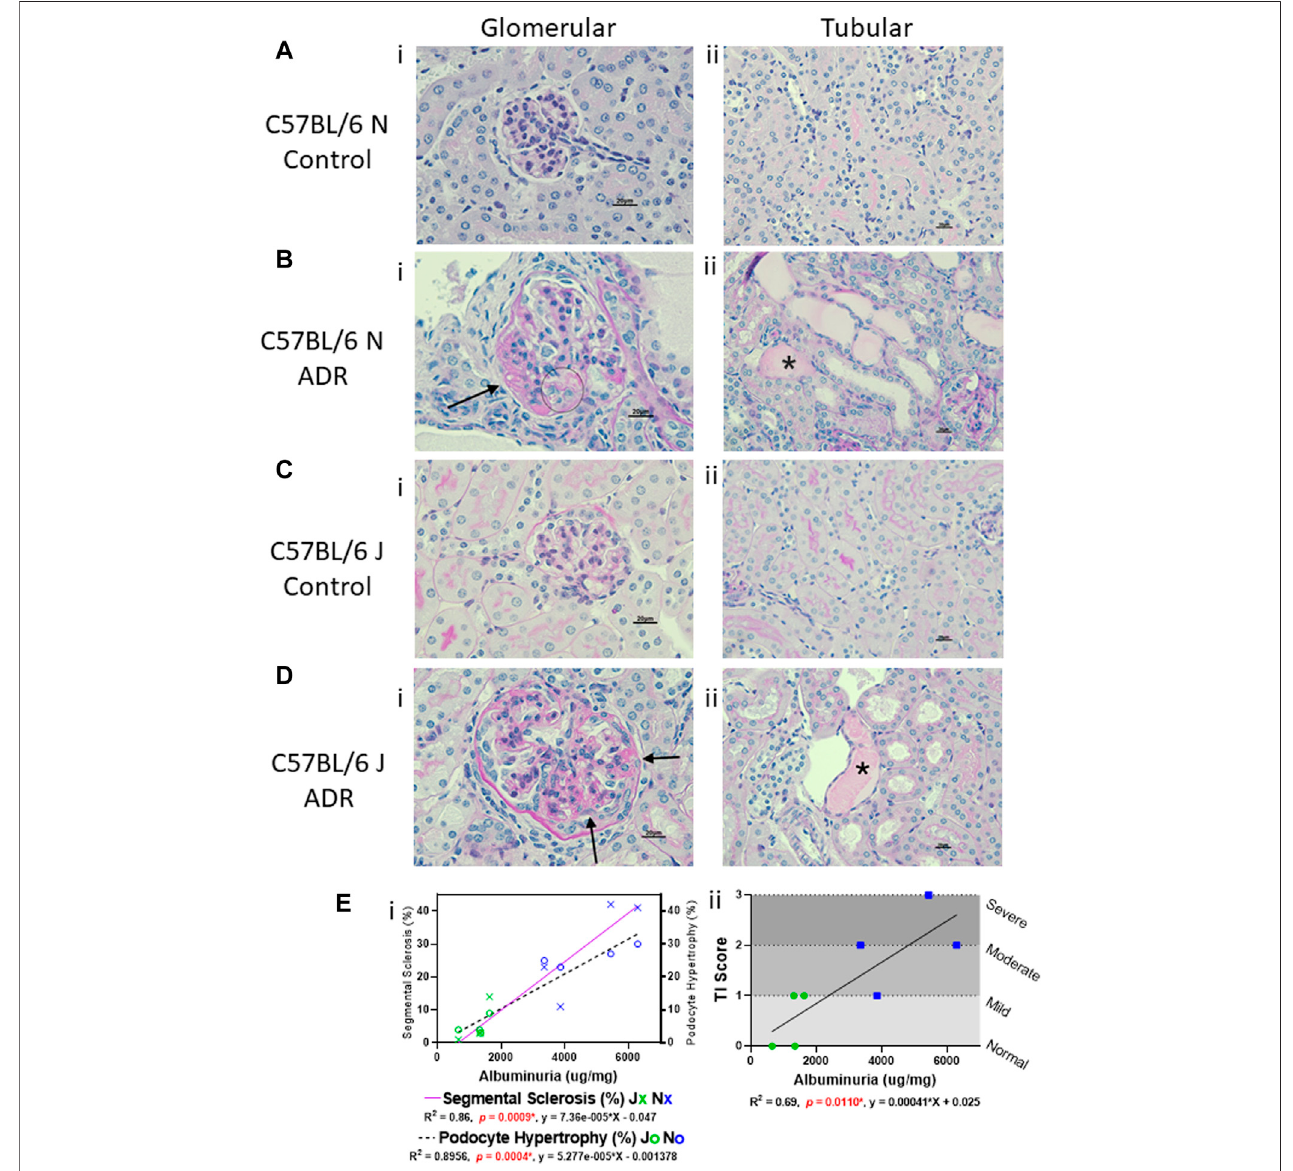
FIGURE 2 | Glomerular and Tubular Histological Alterations are more Prominent in N vs. J Substrain, and are Correlative with Albuminuria. (A – D) Histologic evaluation of kidneys stained with periodic acid-Schiff method (scale bar = 20 μ m). Representative images showing (i) glomerular and (ii) tubular histology from (A,B) C57BL/6 N control and ADR-injected mice, and (C,D) , C57BL/6 J control and ADR-injected mice. (Bi and Di) Glomerular damage is indicated with an arrow for a scleroticsegmentandcircleforhypertrophiedpodocytesthatcontainproteinreabsorptiondroplets. (BiiandDii) Tubularproteincastsareindicatedwithasterisks (*). (E i) Correlation of glomerular segmental sclerosis and podocyte hypertrophy with albuminuria in J and N ADR-injected mice. Segmental sclerosis is indicated with a purple solid line, and the data points are marked as X ’ s (Blue = N, Green = J). Podocyte hypertrophy is indicated with a dashed line, and the data points are marked as circles (Blue = N, Green = J). (E ii) Correlation of tubular injury (TI) scores with albuminuria in J and N ADR-injected mice (Blue = N, Green = J). The tubular injury was scored subjectively with 0 = normal, 1 = mild, 2 = moderate, 3 = severe.